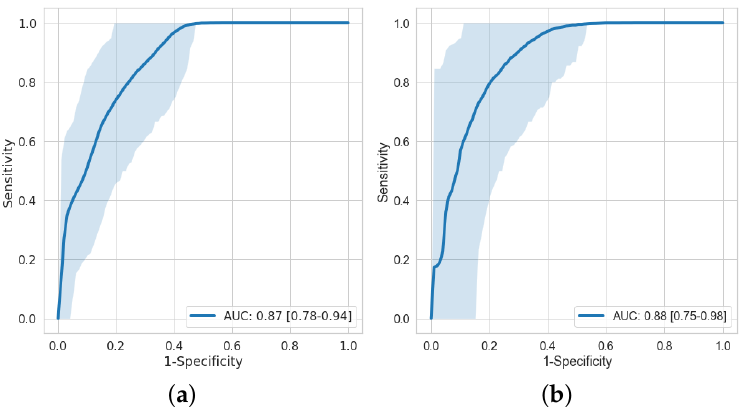
Figure 4. ROC curve on feature engineering with ( a ) macular microvasculature density features and ( b ) age-stroke-controlled macular microvasculature density features.